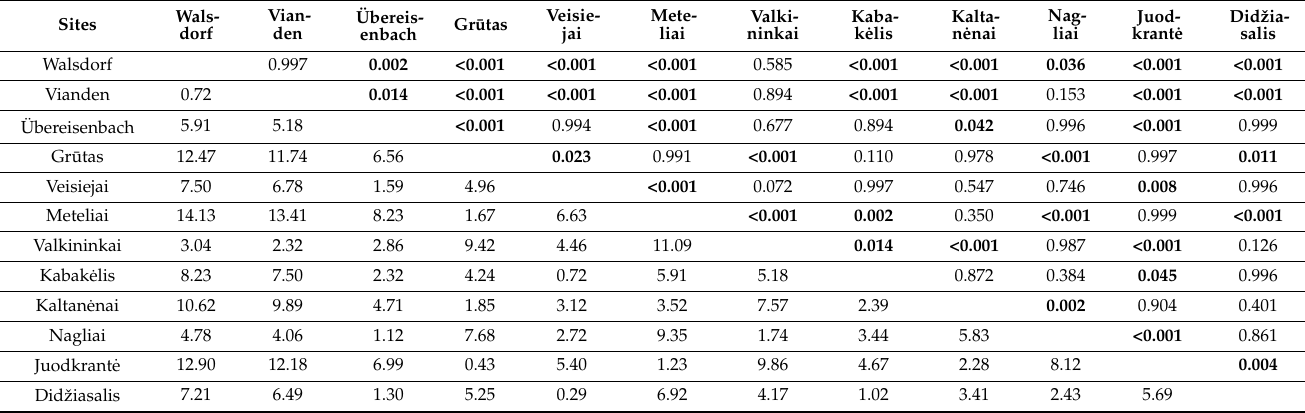
Table A4. Results of pairwise comparisons of the number of aborted ovules between sites using Tukey’s post-hoc